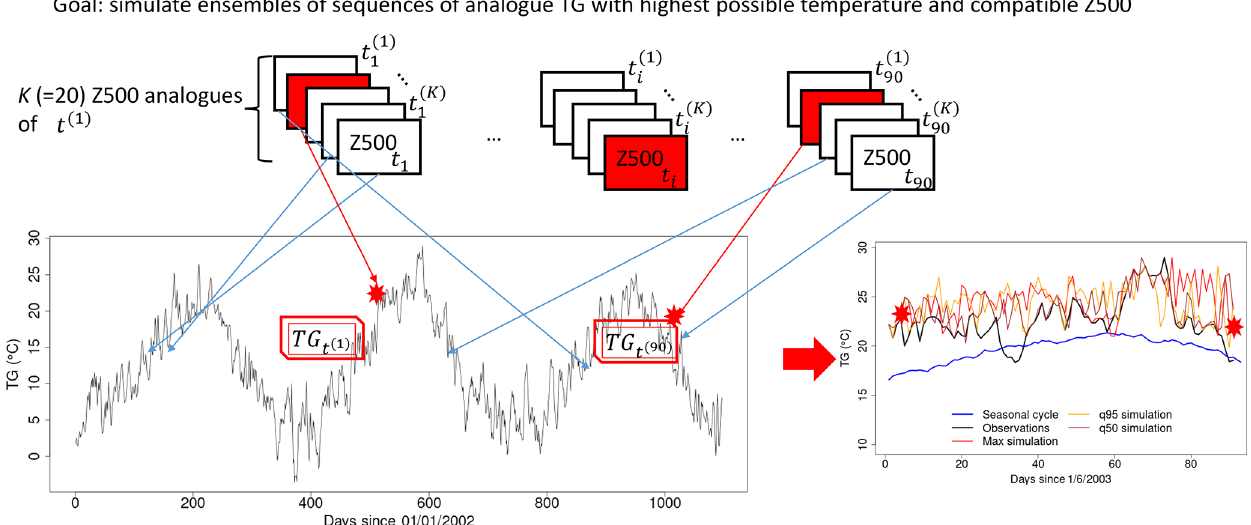
Figure 2. Illustration of the analogue importance sampling for mean daily temperature (TG). The red rectangles indicate the selected Z500 analogues for date t (i) . The red stars in the lower graphs are the temperature values during the selected analogue date. Blue arrows indicate the correspondence between Z500 analogues and daily TG. Here, TG is the daily mean temperature for the Berlin–De Bilt–Orly–Toulouse– Madrid (BDOTM) average. Panel (b) illustrates simulated TG (red, orange and brown lines); the black line is the observed TG; the blue line is the seasonal cycle of